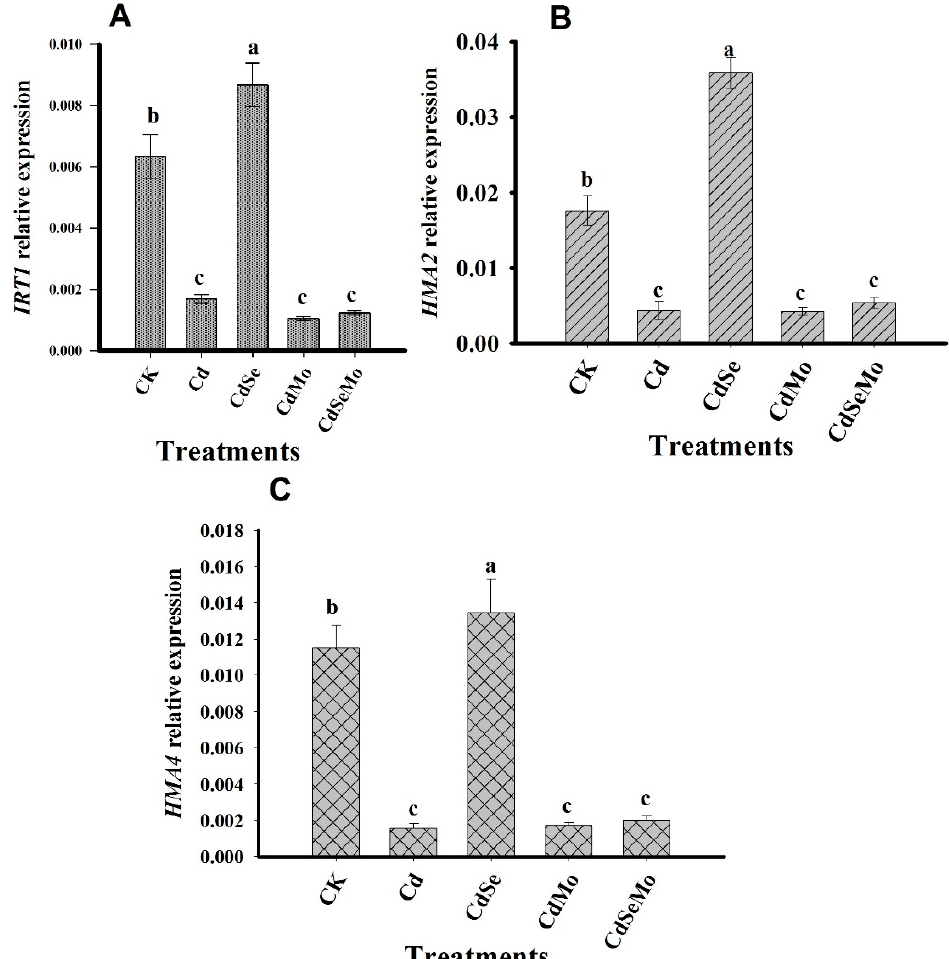
Figure 11. Expression profiles of IRT1 ( A ), HMA2 ( B ), and HMA4 ( C ) in roots of B. napus . Vertical bars indicate standard error of each mean ( n = 3). Different letters within a column indicate significant differences between treatments at ( p < 0.05). The relative expression levels were calculated by comparing the cycle thresholds (CTs) of the target genes with that of the reference gene BnActin using the 2 −ΔΔ C t method.